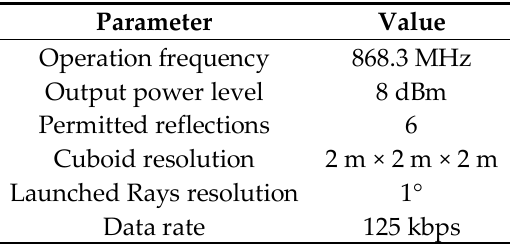
Table 1. 3D Ray Launching